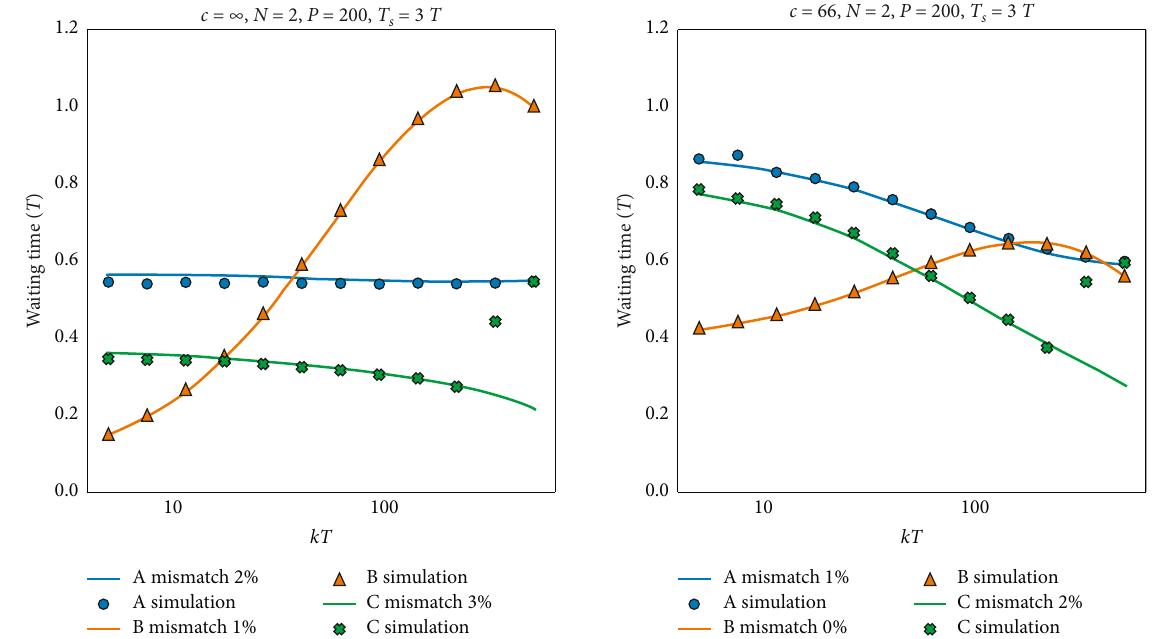
Figure 1: Comparison of the average waiting time of passengers computed with analytical formulas and with a numerical simulation. The plot on the left considers the case of unlimited capacity described in Section 2, while the plot on the right considers a limited capacity of c � ⌊ P /3 ⌋ and uses the formulas from Section 3. The circles, triangles, and crosses represent the results from the simulation for the cases A, B, and C, respectively. Discrepancies are caused by simplified assumptions, discretisation of variables in the simulation, and limited running time. The percentage of mismatch in the legend is the median of the difference between the simulation and the analytical result across the range kT , rounded to the closest integer. As explained in Section 2.3, the hypothesis of perfectly staggered buses C fails at high values of k , as we see from the plot. In this example, there are two buses ( N � 2 ) , the period of revolution is T � 1000 time units, the period of the spike is T � 3 T , and P � s